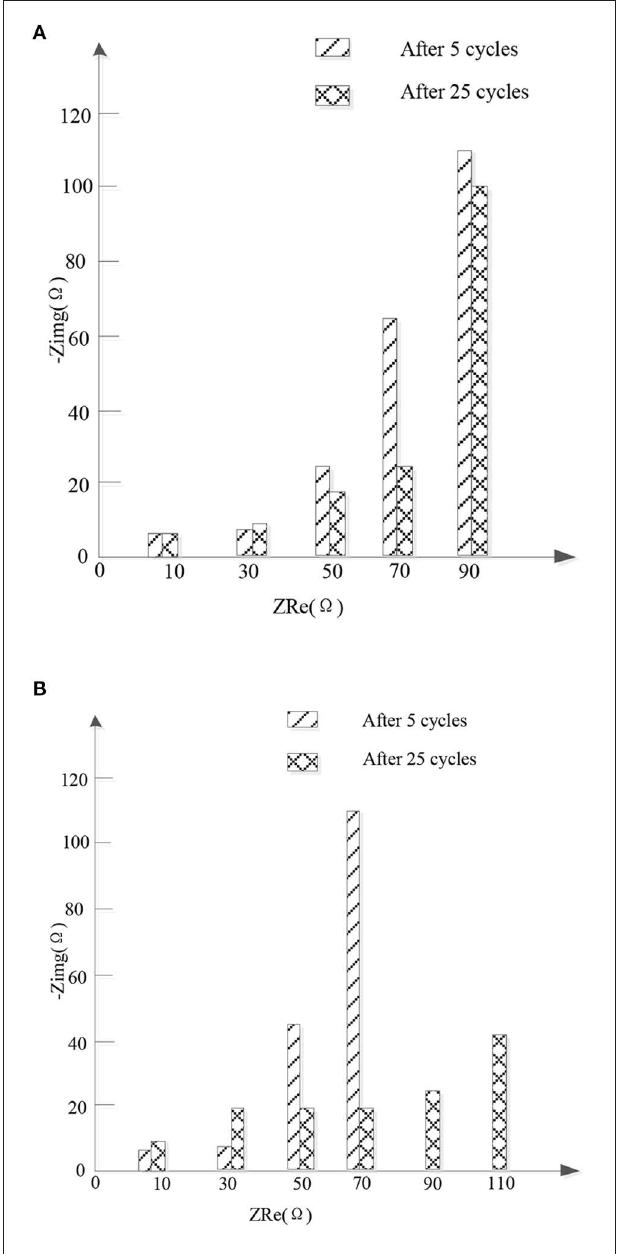
FIGURE 6 | Nyquist conditions of new high entropy alloy and FeSn 2 material samples after 5 and 25 cycles. (A) High entropy alloy new material. (B) FeSn 2